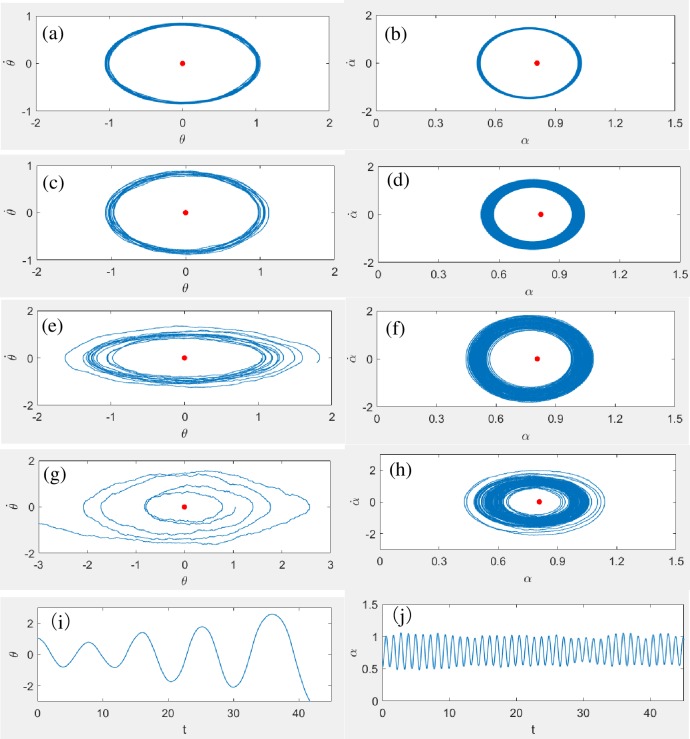
The dynamic simulations under the randomly uncertain disturbances with different amplitudes.(a) and (b): the amplitude of the disturbances is Ai = 0.05 (i = 1, 2); (c) and (d): the amplitude of the disturbances is Ai = 0.5 (i = 1, 2); (e) and (f): the amplitude of the disturbances is Ai = 5 (i = 1, 2); (g)-(j): the amplitude of the disturbances is Ai = 20(i = 1, 2).